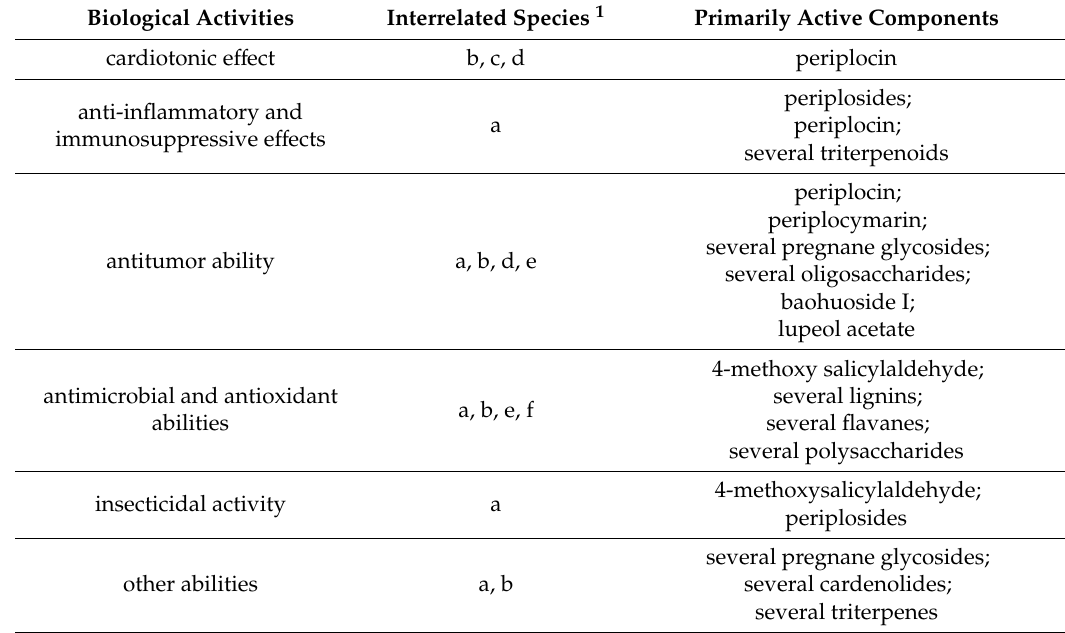
Biological activities of the genus Periploca , primarily interrelated species and active